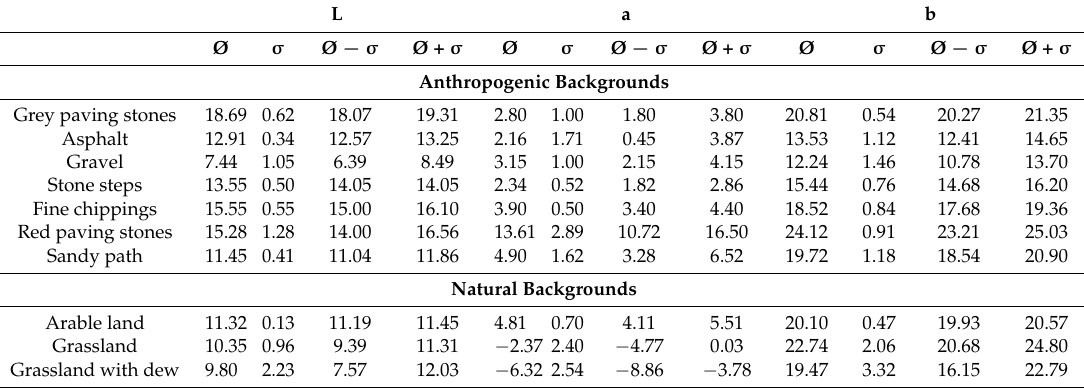
Table 2. Statistical description of reflection values of selected anthropogenic and natural backgrounds by the mean Ø and standard deviation σ .